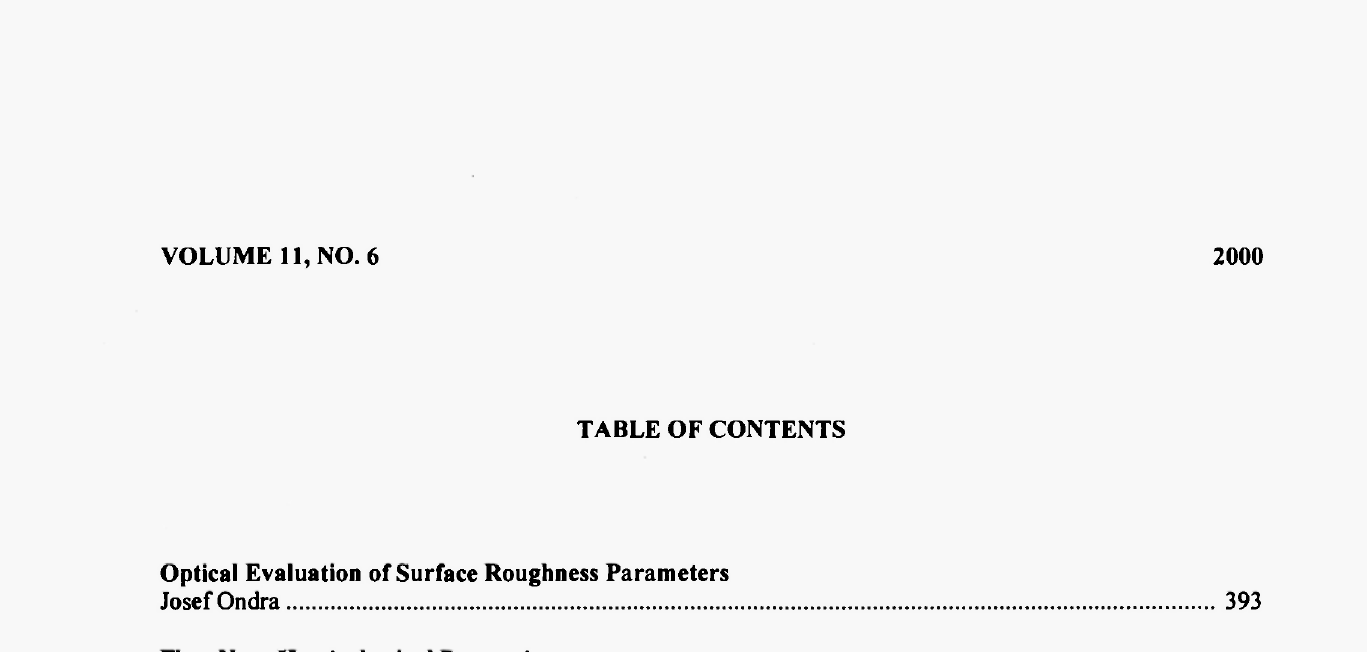
Optical Evaluation of Surface Roughness Parameters Josef Ondra Flow Near Hemispherical